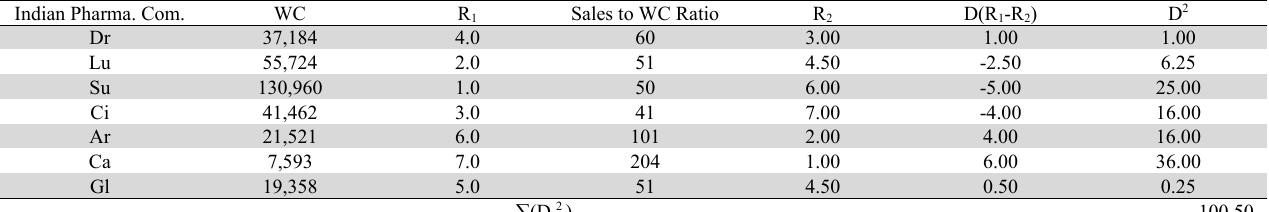
Relational co-movement of working capital and PBT to working capital ratio of selected leading pharmaceutical companies of India Indian Pharma.